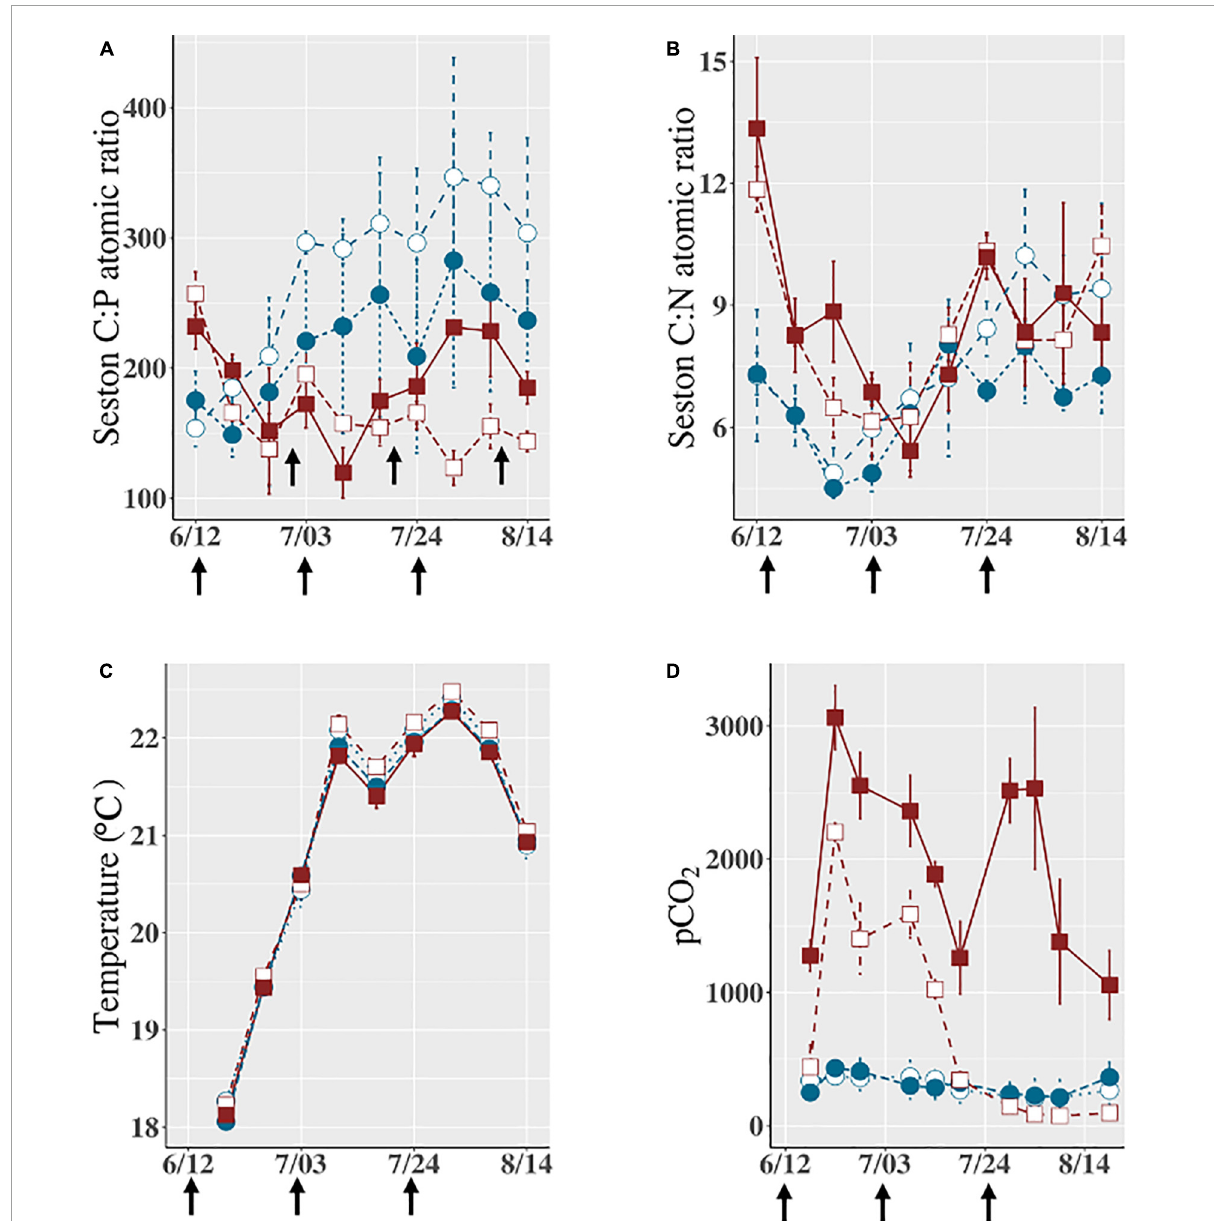
FIGURE2 Changes in (A) Seston C: P atomic ratio, (B) seston C: N atomic ratio, (C) water temperature during the experiment from 12 June to 14 August 2017, and (D) p CO 2 that was measured beginning on 15th June. White squares indicate the LA treatment (unshaded, with leaf homogenate), brown squares indicate the DA treatment (shaded, with leaf homogenate), white circles indicate the LB treatment (unshaded, without leaf homogenate), and blue circles indicate the DB treatment (shaded, without leaf homogenate). Vertical bar on each data point indicates ± SD on the mean (3 replicates). The black arrows at the bottom of the graph are the dates when leaf homogenate was added to LA and DA